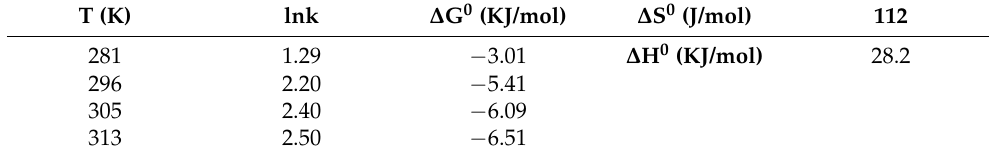
Figure 11. Absorption vs. wavelength spectrum of RF/TiO 2 dispersed in ethanol measured through UV-Vis spectrophotometer, inset shows calculated band gap of synthesised RF/TiO 2. The photodegradation of MB dye, that is, the reduction in concentration with time is recorded in Figure 12 and the recorded data is modelled using pseudo first order kinetics, shown in Figure 12a,b. The data are fitted to the first order kinetic equation (ln (C o /Ce) =